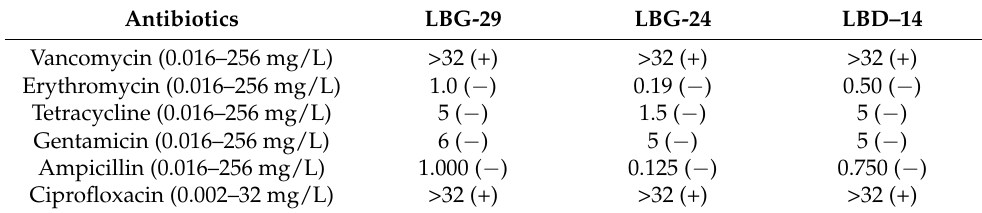
Table 5. Antibiotic susceptibility and minimum inhibitory concentration of the three Levilactobacillus brevis